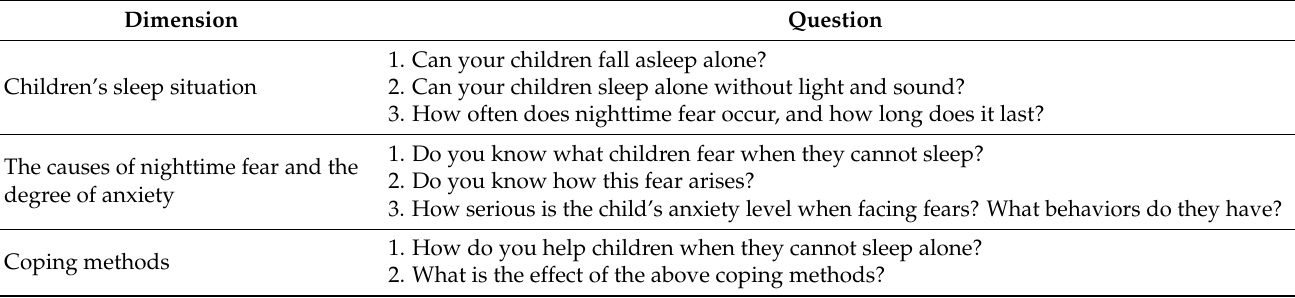
Table 1. Outline of the focus group interview (FGI) for parents.